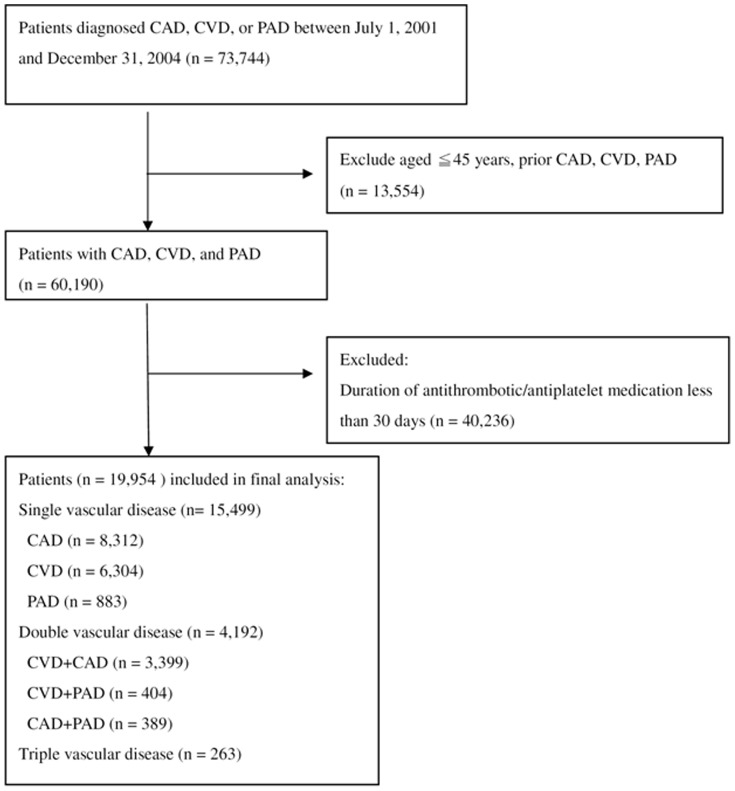
Flow chart of study participants.CVD, cerebrovascular disease; CAD, coronary artery disease; PAD, peripheral arterial disease.